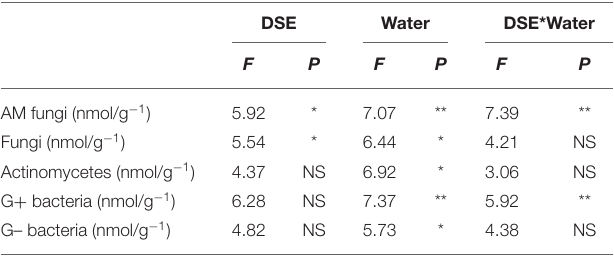
TABLE 5 | Two-way ANOVA of the effect of DSE and water condition on soil microbial content of Lycium ruthenicum